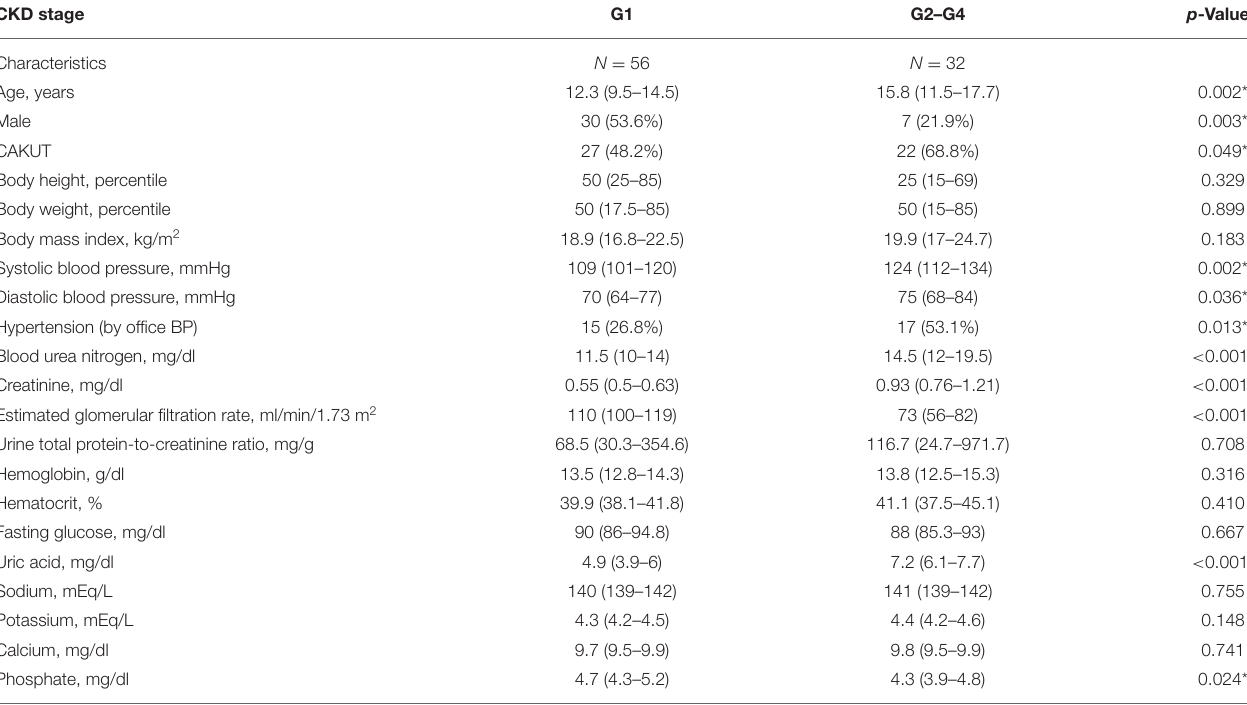
TABLE 2 | Clinical anthropometric and biomedical characteristics of study population ( n = 88).